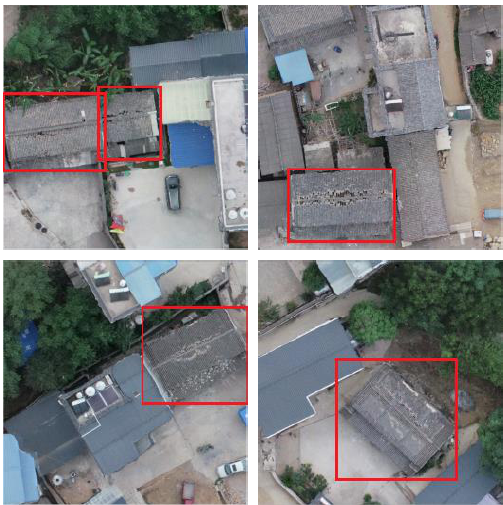
Figure 5. The samples of damaged houses by the Yangbi Earthquake. The red boxes are the bounding boxes for damaged